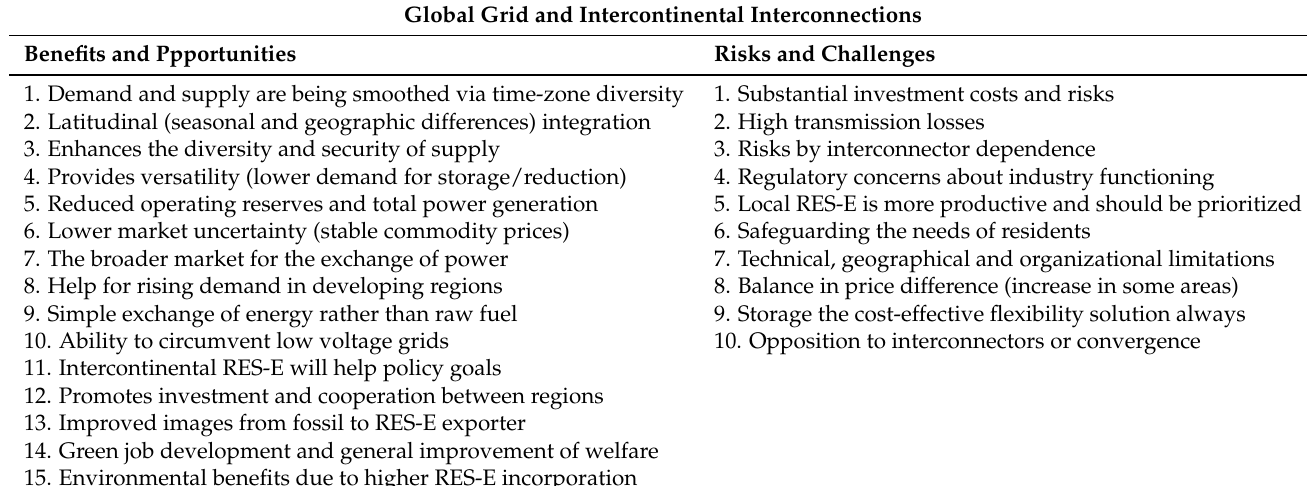
Table 6. Advantages and challenges for the global and intercontinental power grid interconnections